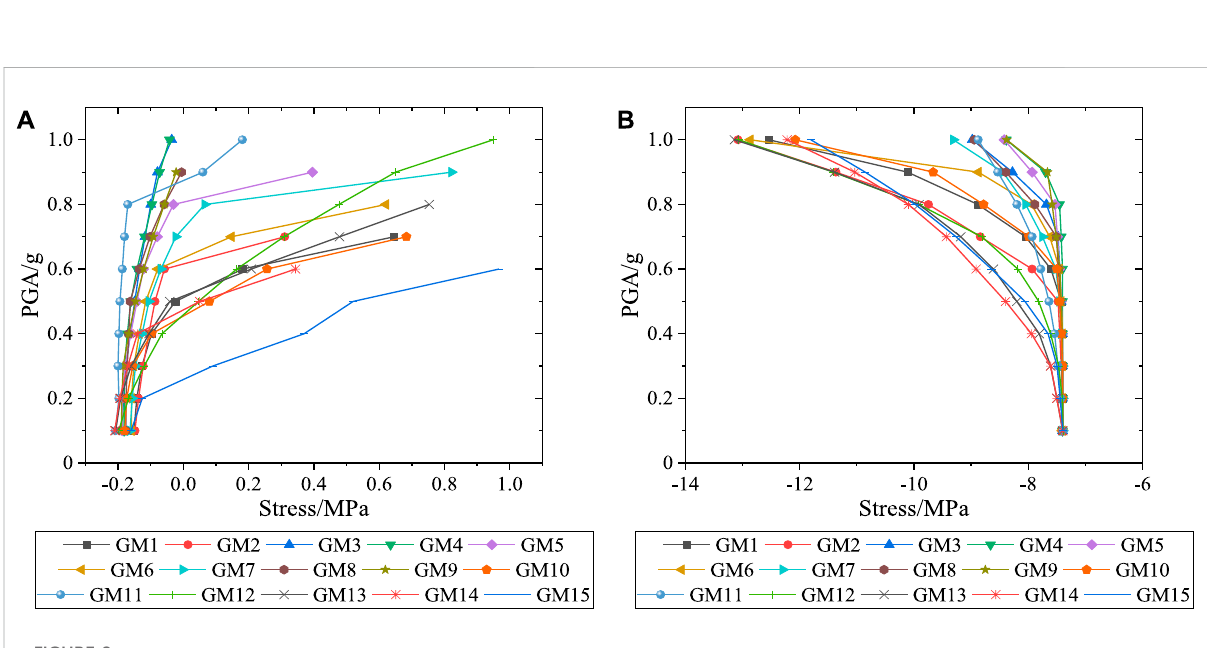
Upper isolated layer: (A) Maximum vertical stress, (B) Minimum vertical